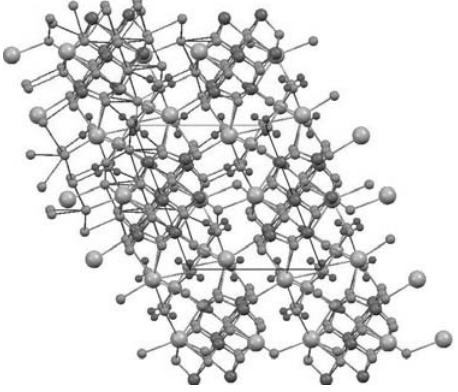
Figure 3. Unit cell of K